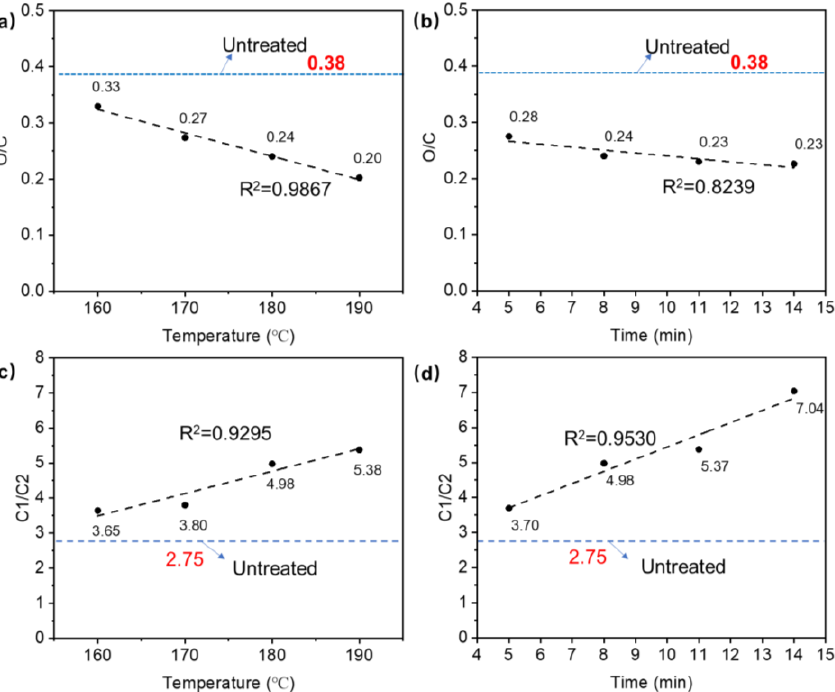
Figure 5. Effect of temperature and duration on the O/C ratio and the C1/C2 ratio of TPM-treated thick veneer: ( a ) correlation between the temperature and the O/C ratio; ( b ) correlation between the duration and the O/C ratio; ( c ) correlation between the temperature and the C1/C2 ratio; and ( d ) correlation between the duration and the C1/C2 ratio. The dashed line in each figure represents the ratios of the untreated samples.